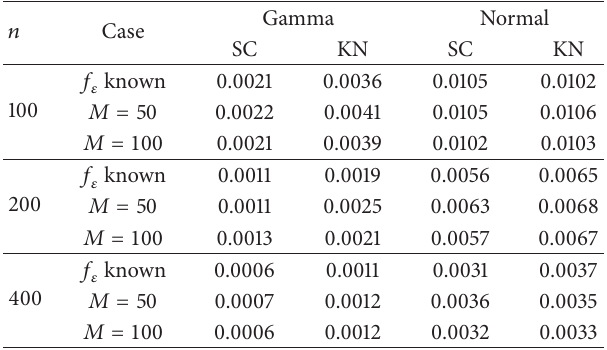
Table 1: MISE for the self-consistent estimator and the kernel estimator when the error distribution is double exponential.